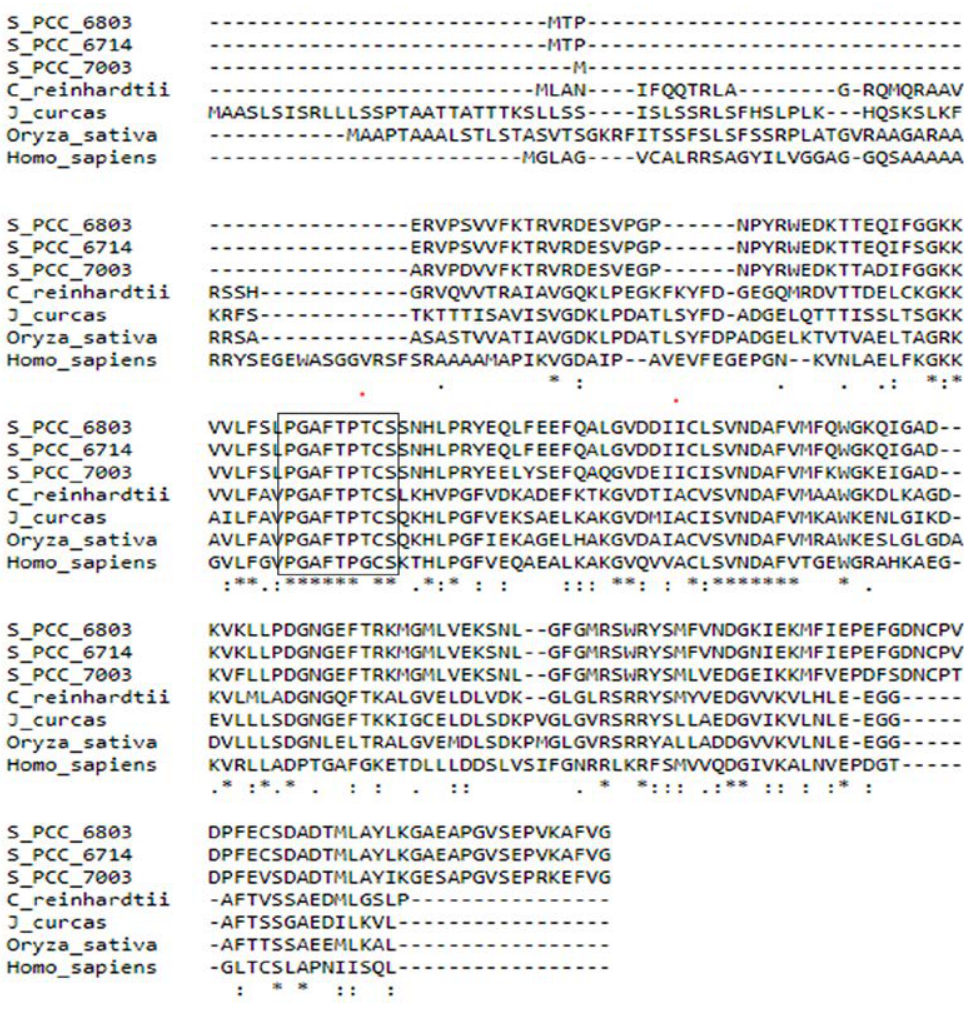
Fig. 1. Comparison of the deduced amino acid sequences of Synechocystis PCC 6803 type II Prx (189 aa) with those of the type II Prx proteins from Synechocystis PCC 6714 (189 aa), Synechococcus PCC 7003 (187 aa), Chlamydomonas reinhardtii (194 aa), Jatropha curcas (227), Oryza sativa subsp. japonica (225 aa), and Homo sapiens (214 aa). Amino acid sequences were aligned by CLUSTALW method using MAFFT v7.429. The active site is pointed out by black frame, and the two conserved cysteine residues are marked by red